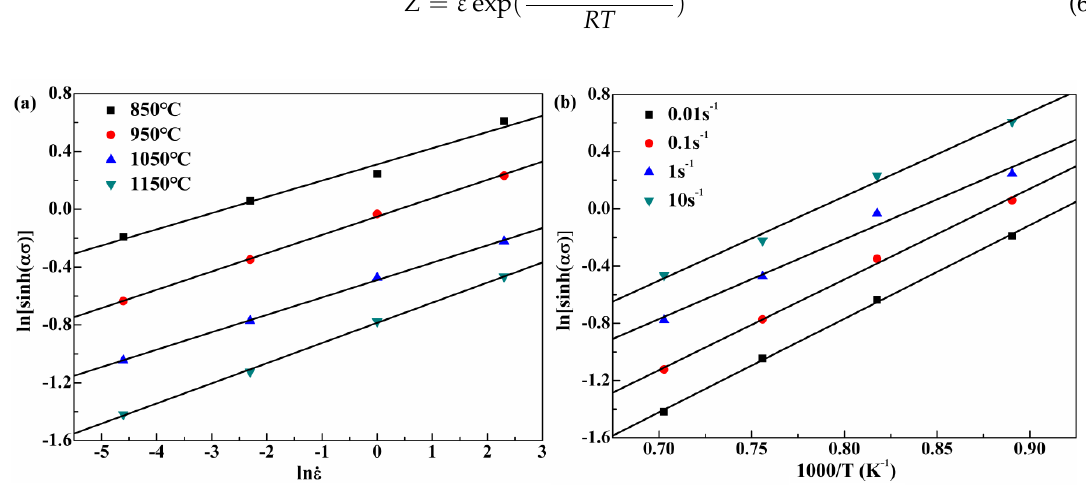
Figure 5. plots under different temperature; and 1000 / T  plots at different strain rates. . ε Figure 5. ( a ) ln [ sinh ( ασ )] − ln plots under different temperature; and ( b ) ln [ sinh ( ασ )] − 1000/ T plots at different strain rates.